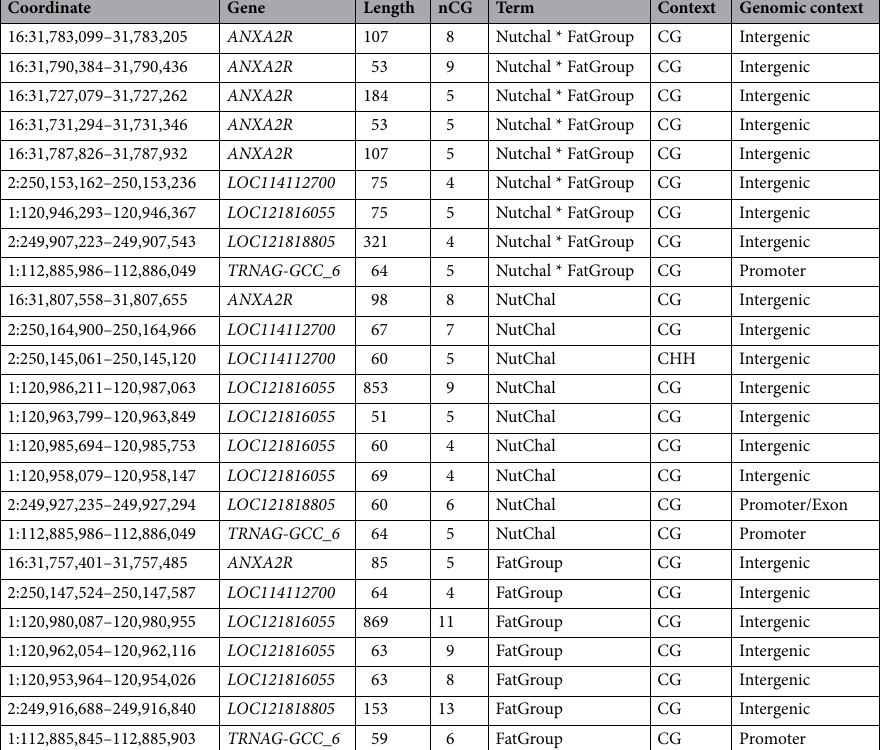
Table 2. Genes harboring differentially methylated regions and shared among all the three terms for the multifactorial model (Nutchal * FatGroup, NutChal, and